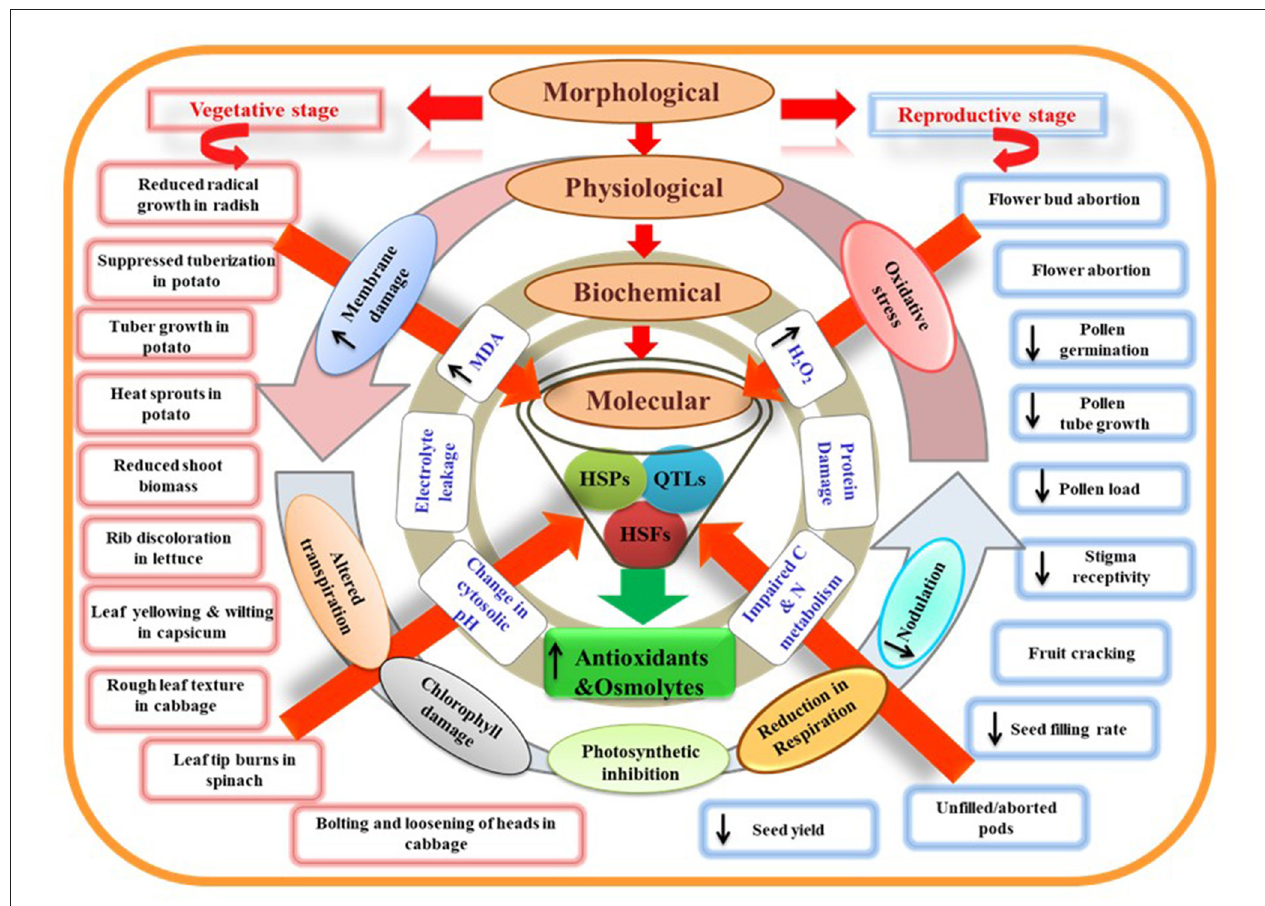
FIGURE 3 | Model representing morphological, physiological, biochemical, and molecular characteristics of plants under heat stress. Morphological damages at vegetative and reproductive stages can be visualized as direct measures of plant stress. At the physiological level, these damages are associated with leaky plasma membrane, altered transpiration, chlorophyll damage, reduced photosynthesis, respiration, and nodulation rate. Disturbed physiological processes can promote oxidative stress damage observed through stress indicators like increased malondialdehyde ( MDA ) and hydrogen peroxide (H 2 O 2 ) content. Protein damage and impaired carbon and nitrogen metabolism due to impaired enzymatic activities further exaggerate stress levels at the biochemical level. Heat shock proteins (HSPs), heat shock factors (HSFs), and quantitative trait loci (QTLs) related to heat stress responses of plants may play a key role in the plant adaptation. HSPs and HSFs